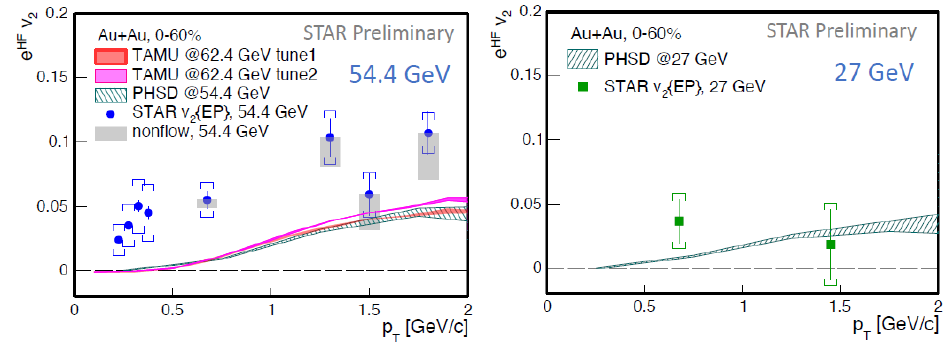
Figure 4: Left: Elliptic flow v 2 of heavy flavor decay electrons vs. p T measured by STAR at 54 . 4 GeV [21]. Right: Similar measurement for 27 GeV [21].